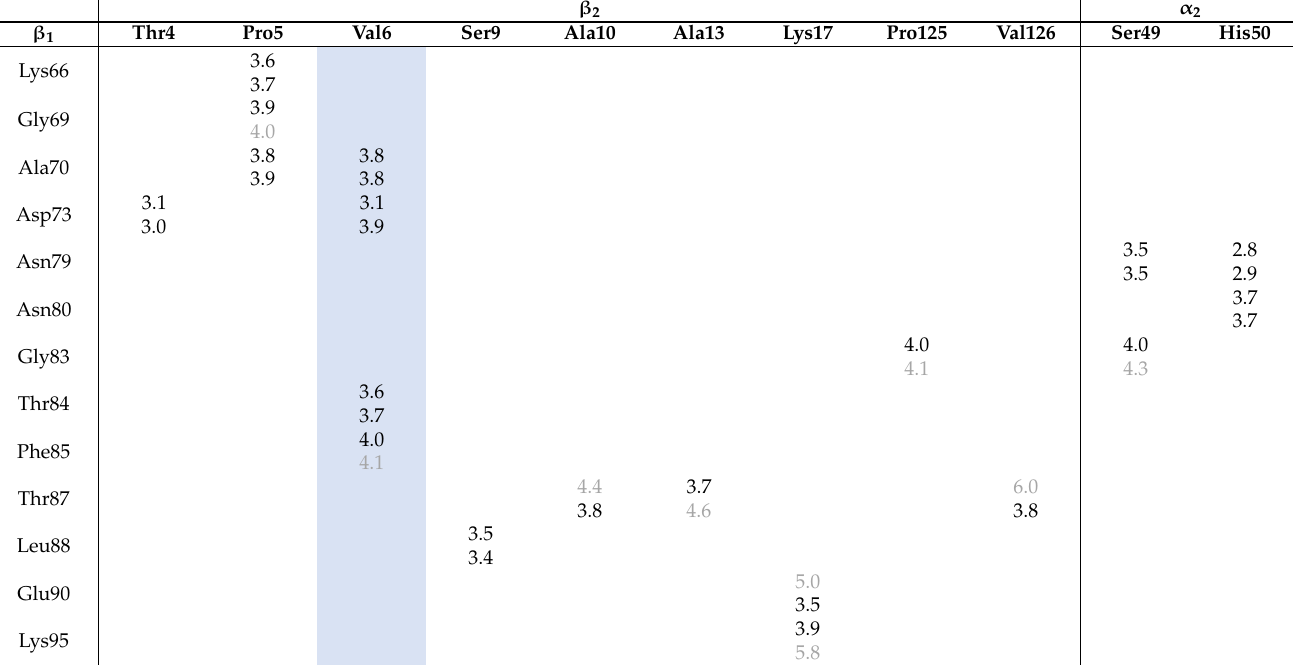
Table 1. Double strand lateral contact distances < 4.0 Å [3]. The two entries refer to the two non- equivalent molecules in the double strand, with the gray entries those that are greater than 4.0 Å. For the atomic details of the contacts, the reader is referred to the original work [3]. The contacts of the mutant Val β 6 are highlighted.